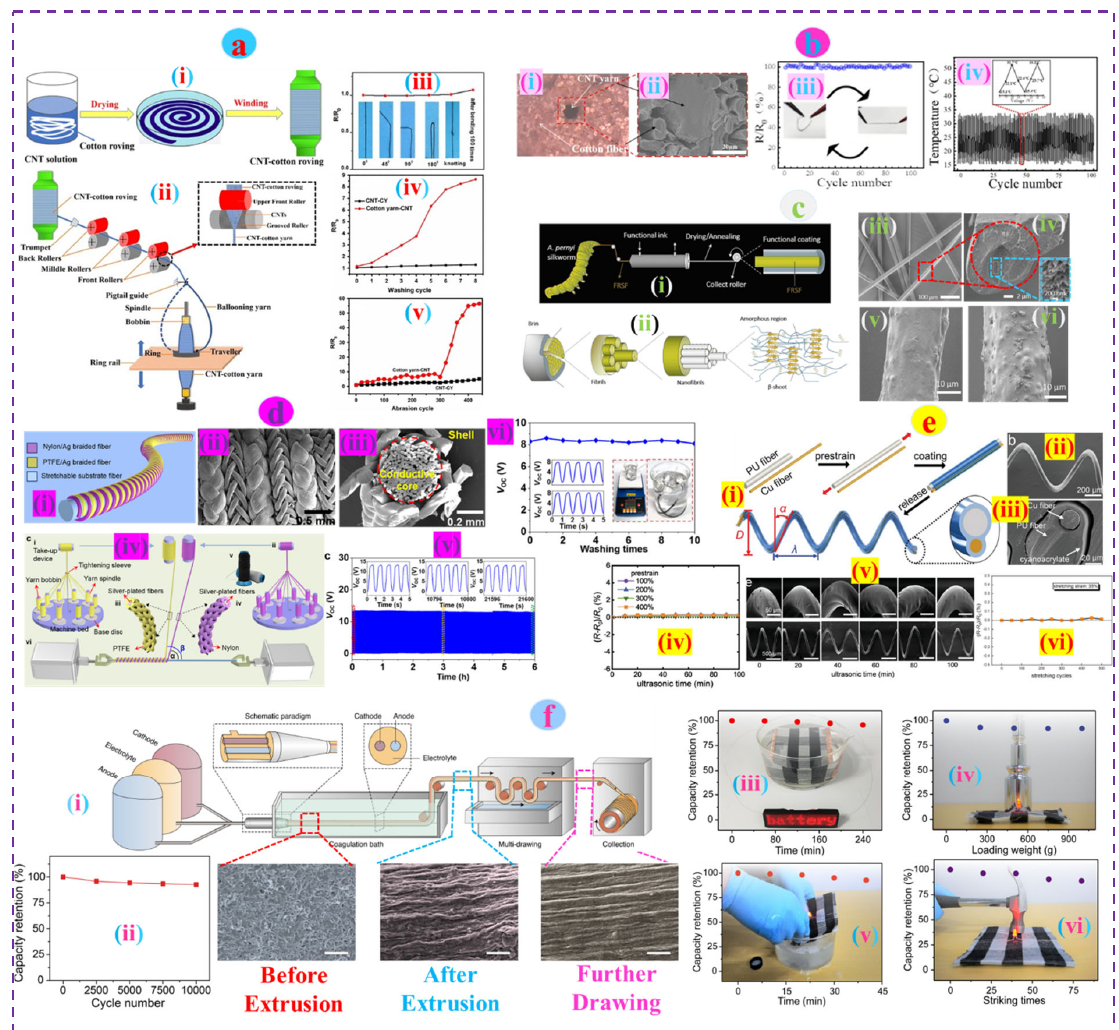
Figure 3. ( a ) Schematic of the roving coating technique (i) and (ii) ring spinning process, resistance change upon repeated bending (iii), washing (iv), and abrasion cycles (v). Reproduced with permission [147] Copyright 2018, Springer. ( b ) Optical image (i) and (ii) SEM image of the core-spun yarn, (iii) change of temperature as a function of time, and (iv) cyclic stability under 100 bending cycles. Reproduced with permission [148] Copyright 2022, Springer. ( c ) (i) Schematic of the functionalized silk fiber production, (ii) Structural hierarchy of the developed fiber, (iii,iv) SEM images of the fiber and cross-section, (v,vi) Surface morphology before and after 48 h of wash. Reproduced with permission [150] Copyright 2022, Elsevier. ( d ) (i) Schematic of the stretchable helical